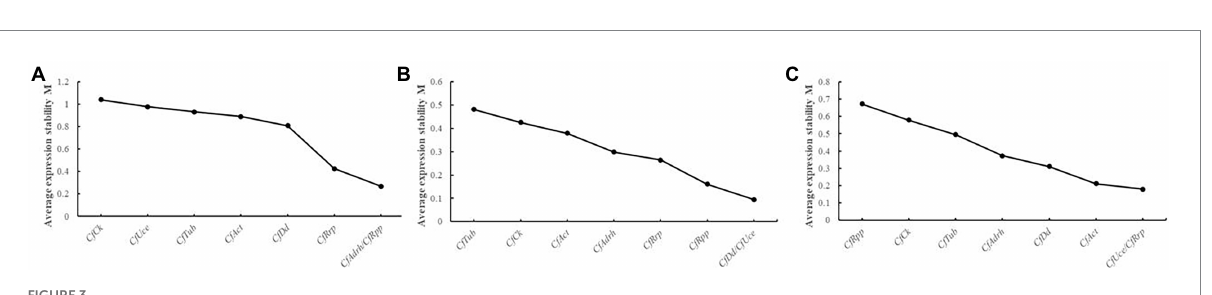
FIGURE 3 geNorm analysis of expression stability of eight candidate reference genes in different groups. (A) Mycelial growth; (B) HJ leaf spot group; and (C) HS leaf spot group. M values represent the gene expression stability index. Higher M values indicate that the gene is more unstable and vice